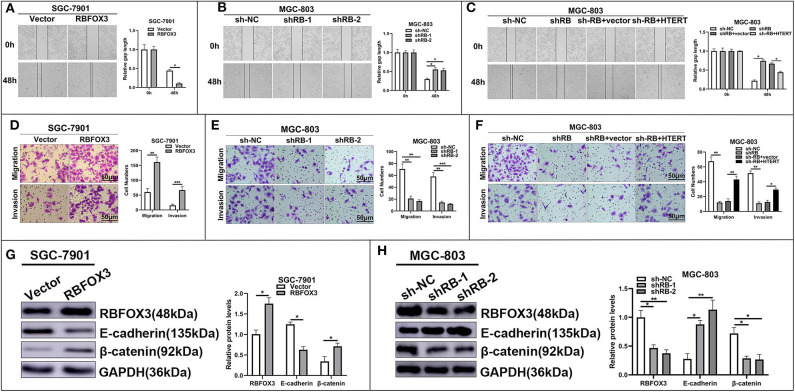
RBFOX3 promoted the migration and the invasion of GC cells in vitro. (A–C) The wound healing assay was performed to investigate the horizontal migration of cells following RBFOX3 overexpression or silencing in SGC-7901 (left panel) and MGC-803 cells (middle panel). Overexpression of HTERT abolished the inhibitory effects of RBFOX3 silencing on cell viability and formation of colonies in MGC-803 cells (right panel). (D–F) Results of the vertical migration and the invasion capacities of cells following RBFOX3 overexpression or silencing in SGC-7901 (left panel) and MGC-803 (middle panel) cells. (G,H) Western blotting results showing the protein expression of metastasis-related proteins following RBFOX3 overexpression or silencing in SGC-7901 and MGC-803 cells. *p < 0.05, **p < 0.01, ***p < 0.001.